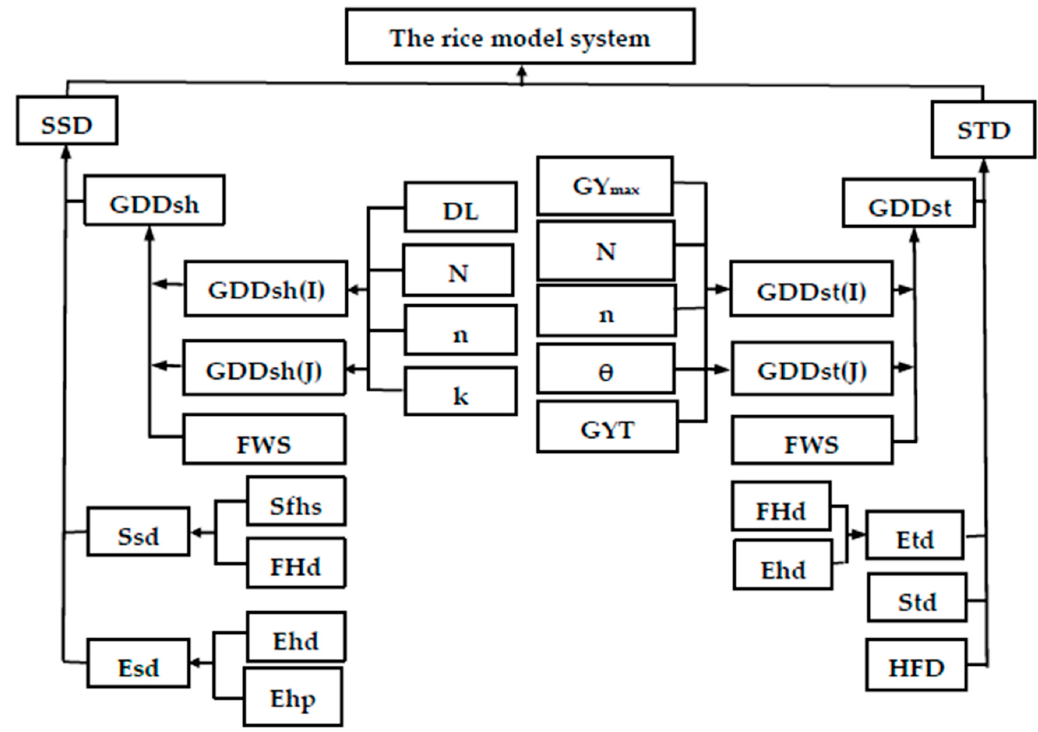
Figure 1. The structure of rice model system. Lines connecting the boxes and single-headed arrows indicate the one-way flow of information. Abbreviations are listed in Table 5. Table 5. Abbreviations of the variable